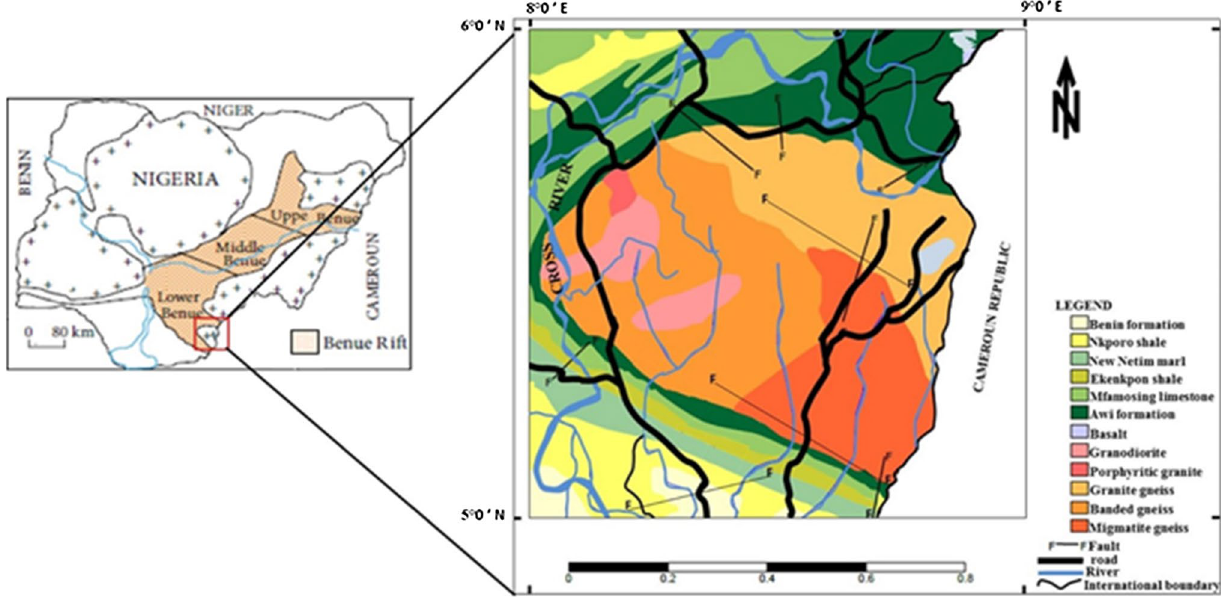
Fig. 1 Geologic map of the study